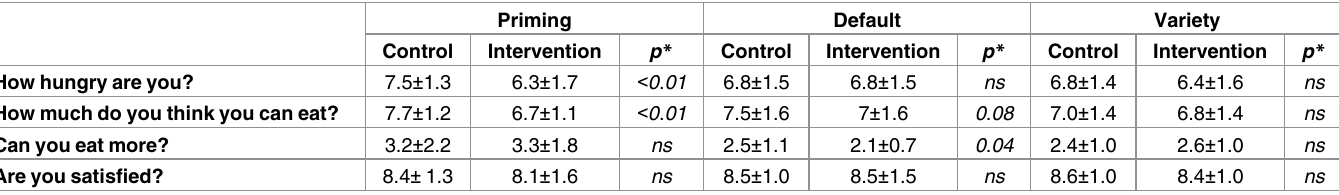
Table 2. Appetite score from control day and intervention day. Measurement scale used: 10 point Likert scale anchored from “I am not at all” (score: 1) to “I have never been more” (score: